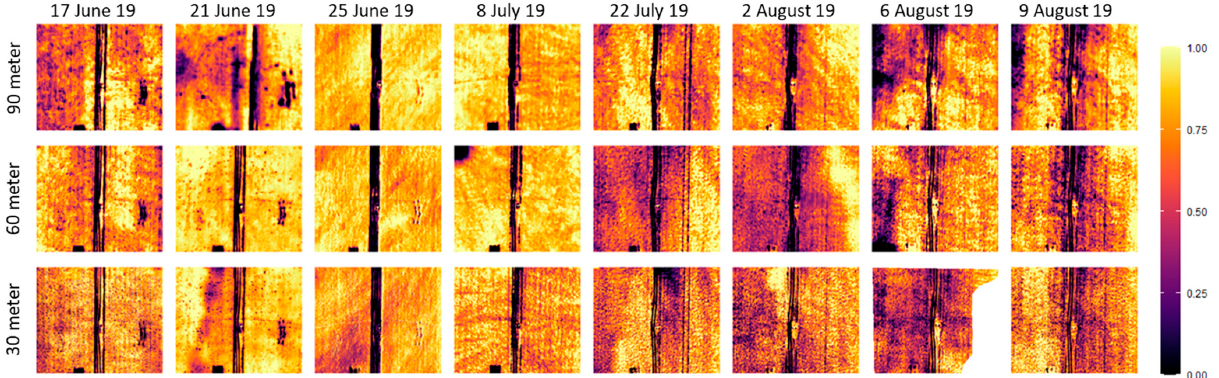
Figure 7. Relative ET raster maps for each mission based off HRMET-derived ET. Relative ET is the standardized ET using the plots 5th and 95th percentile as the boundaries.